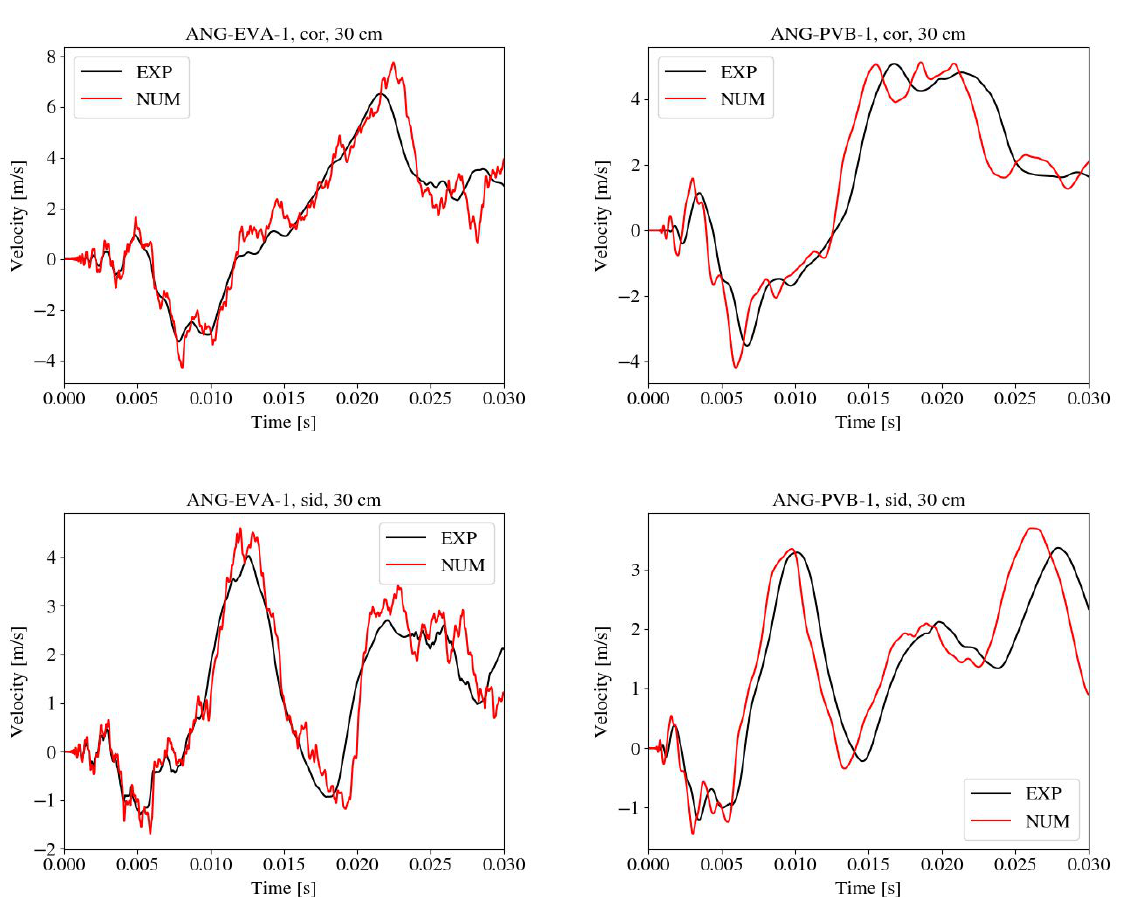
Fig. 11 Validation of velocities from numerical analysis (NUM) against experimental data (EXP) at the corner of the plate (cor) and the centre of side edge (sid) for ANG-EVA and ANG-PVB samples for the impact height of 30 cm.